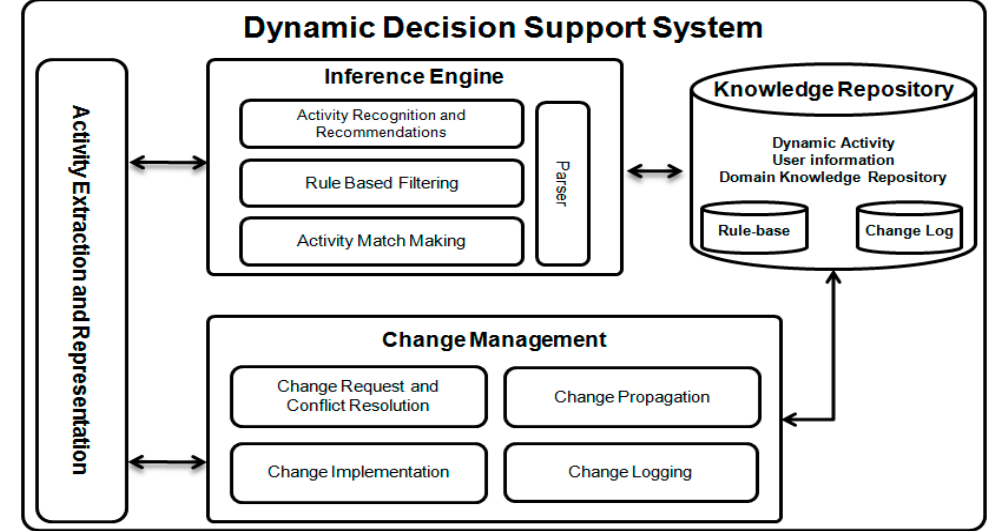
Figure 2. Dynamic Decision Support System (DDSS) architecture for information inflow, processing, and recommendation outflow.